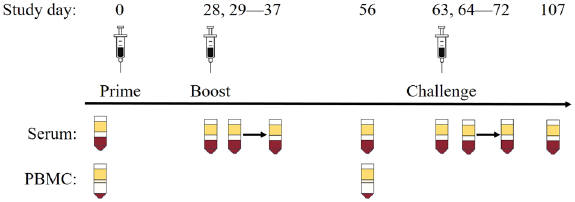
Fig. 1 Vaccination schedule and serum collection by study day. Injections are indicated by a syringe. Serum and PBMC collections are indicated by their respective blood tube